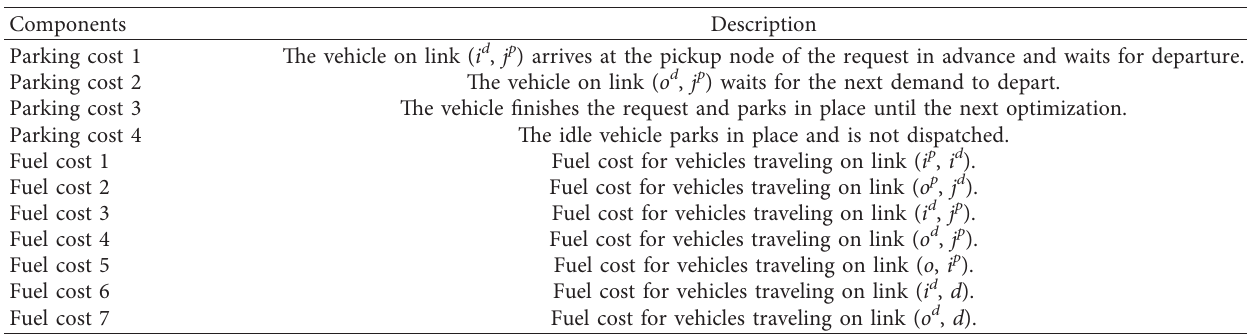
Table 4: Components of parking costs and fuel